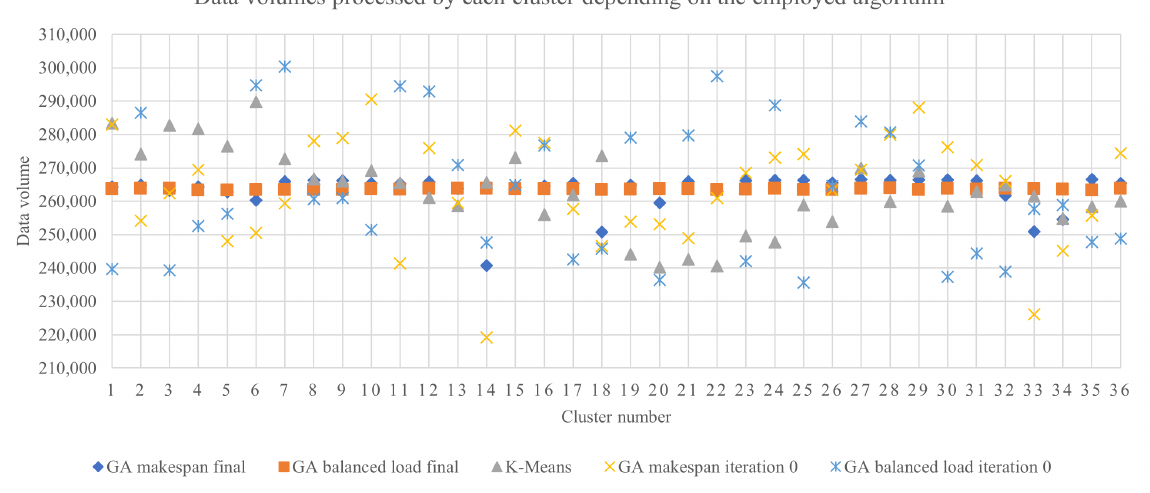
Figure 13. The data volumes that were assigned to be processed by each of the 36 clusters, depending on the employed